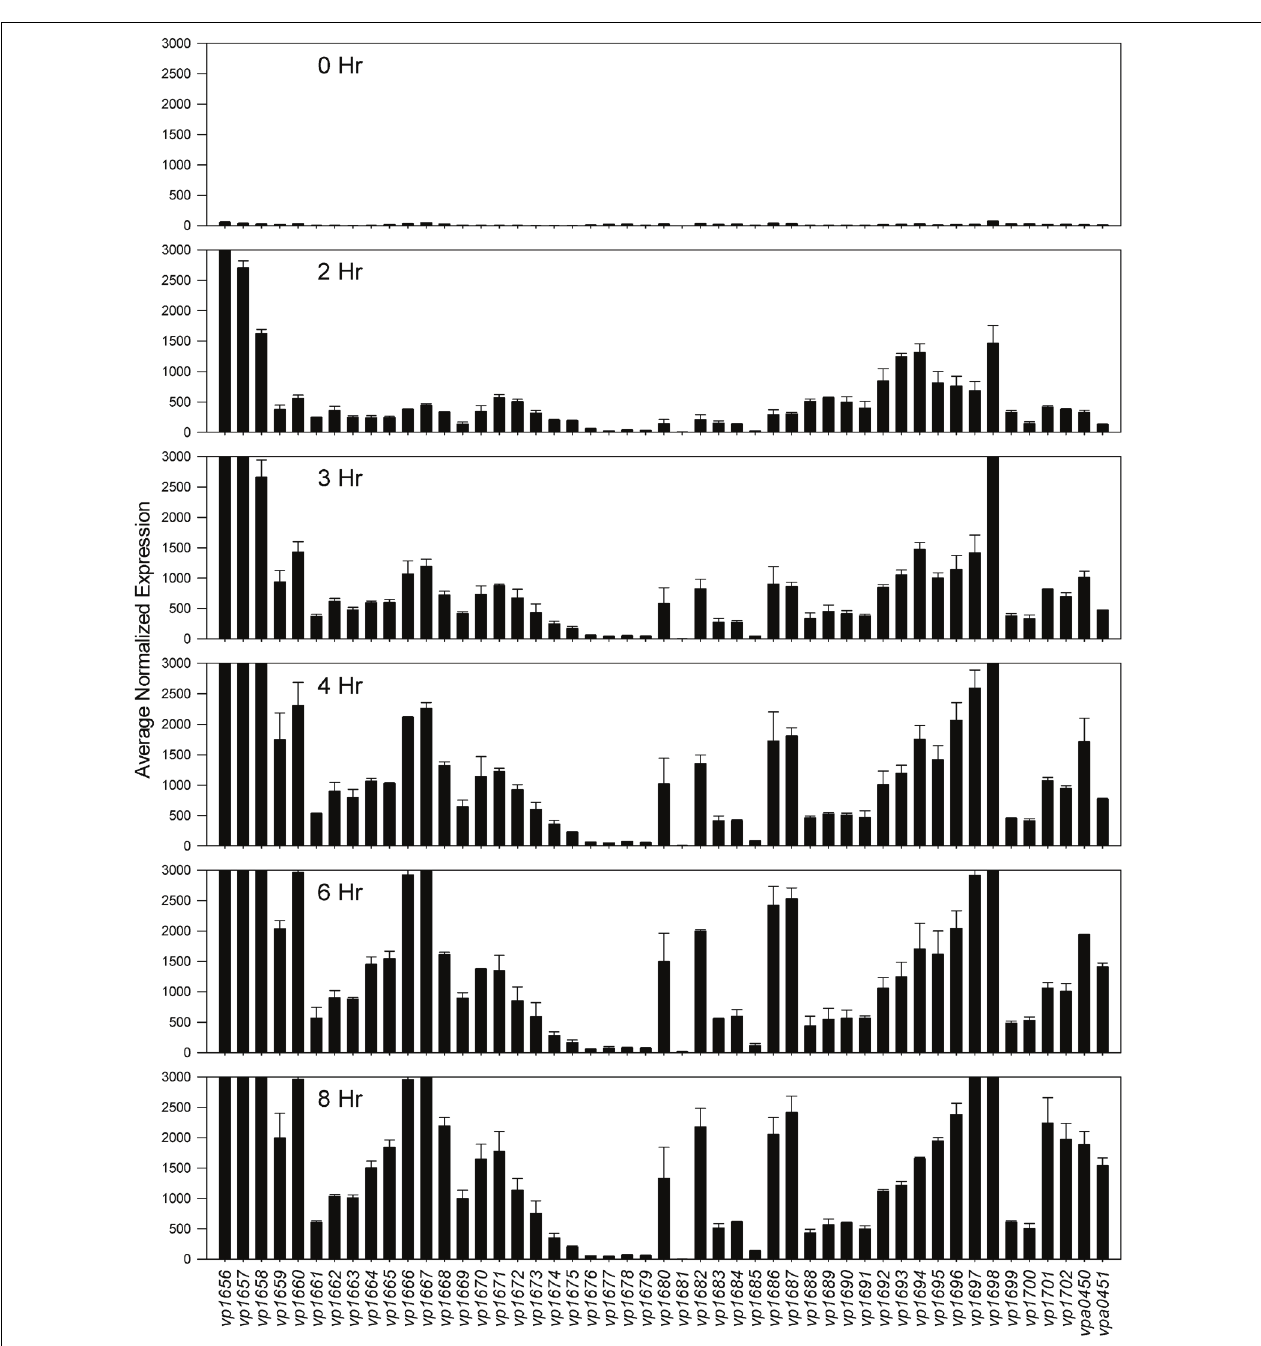
FIGURE 3 | Average normalized expression ( n = 2 replicates) for T3SS1 associated genes ( vp1656 — vp1702 ; vpa0450 — vpa0451 ) at various time points during HeLa cell infection in HBSS/1%